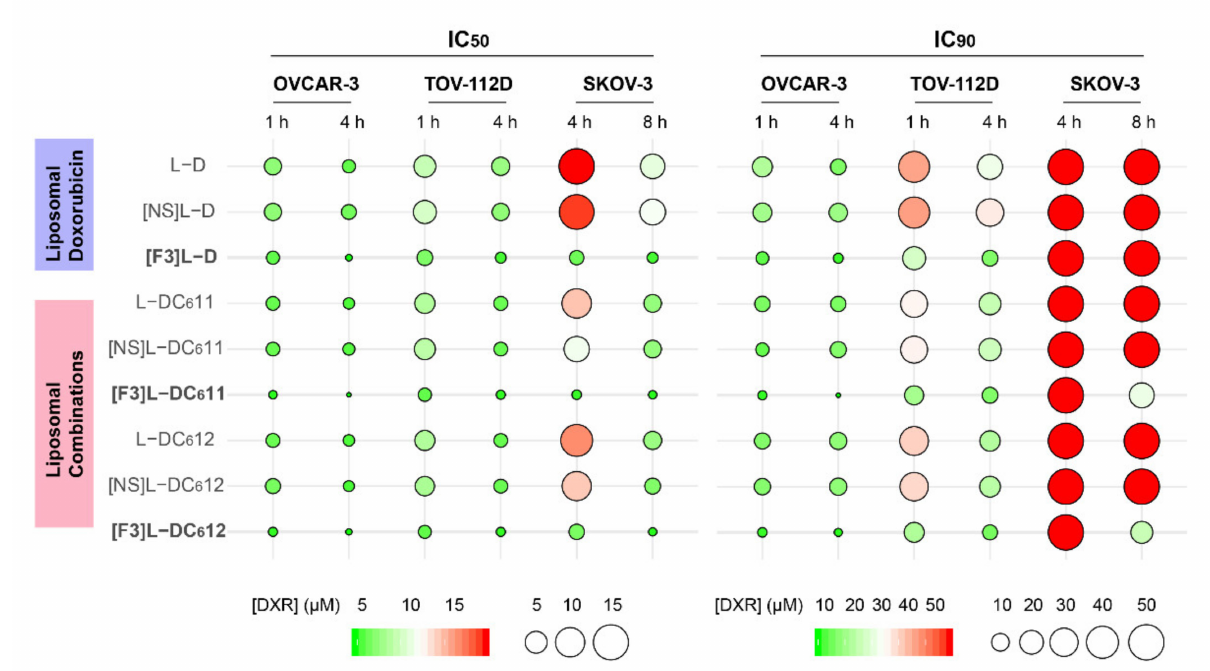
Figure 4. Cytotoxicity of different liposomal combinations of doxorubicin (DXR) and C6-ceramide against ovarian cancer cell lines. The indicated ovarian cancer cell lines were incubated for 1, 4 or 8 h with F3 peptide-targeted liposomal DXR ([F3]L-D) or DXR:C6-ceramide combination at a molar ratio of 1:1 or 1:2 ([F3]L-DC 6 11 and [F3]L-DC 6 12, respectively), at DXR serially diluted concentrations. The experiment was further prolonged for a total of 96 (TOV-112D), 120 (SKOV-3) or 144 h (OVCAR-3) after which cell viability was assessed. Additional controls included liposomes either functionalized by a non-specific peptide ([NS]L-D, [NS]L-DC 6 11 and [NS]L-DC 6 12) or non-targeted (L-D, L-DC 6 11 and L-DC 6 12), incubated under the same experimental conditions. The mean DXR concentrations enabling 50% (IC 50 ) or 90% (IC 90 ) cytotoxicity are presented, where the circle size and color reflected the mean DXR concentration value ( µ M, n = 3): the smaller the size and the greener the color, the higher the cytotoxic